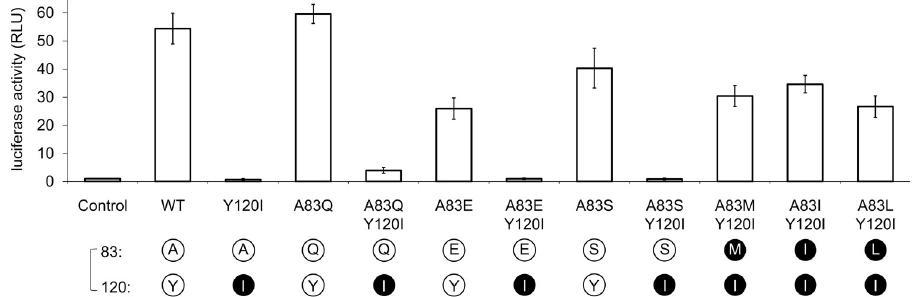
Fig 6. Comprehensive testing of R-clamp residue pairing rules by mutagenesis of SF2-Nef. Nef-induced AP-1 activity in cells transfected without Nef (Control) or with the indicated wild-type or mutant versions of SF2 Nef was analyzed as in Fig 1B. The amino acid combinations at positions 83 and 120 of these SF2 Nef variants are indicated as single-letter symbols that are color-coded as explained in Fig 4.